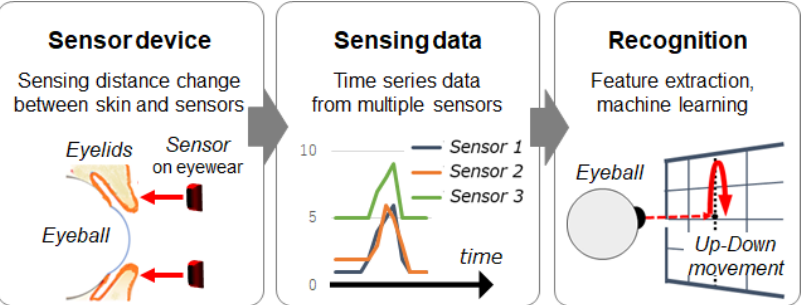
Figure 1. Flowchart of the proposed method. Reprinted with permission from Ref. [25]. Copyright 2021 ACM.